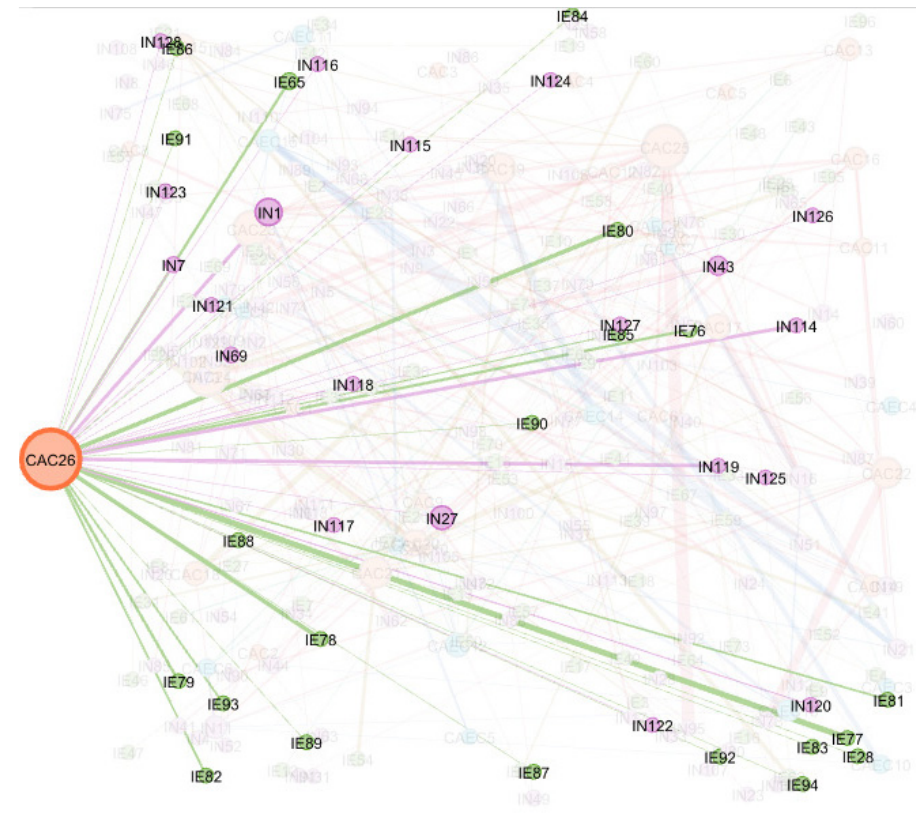
Fig. 5. The research group with the highest degree of collaboration